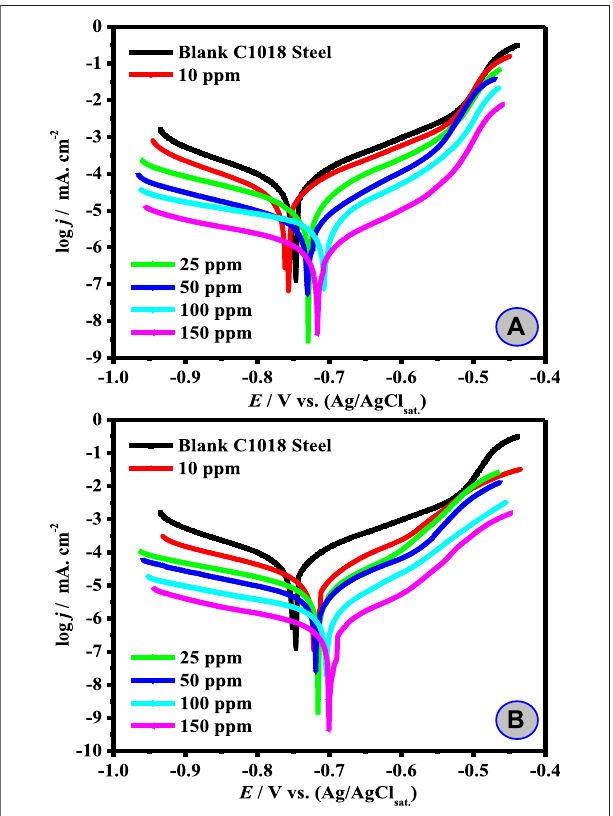
FIGURE 2 | Tafel plots for C1018-steel 3.5% NaCl saturated CO 2 solution without and with different concentrations of (A) CSM and (B) CSD at 50 ± 1 °